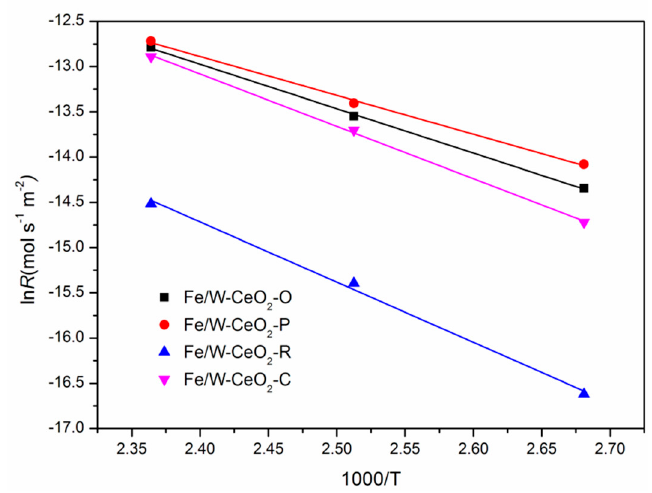
Figure 9. Arrhenius plots of the inherent reaction rate constants of Fe/W–CeO 2 catalysts.